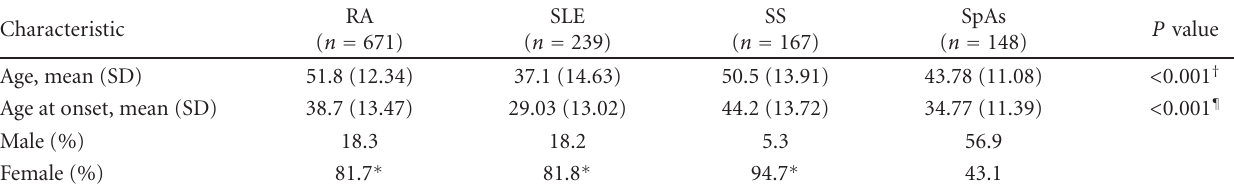
Table 4: Age and gender of patients with ADs and SpAs.